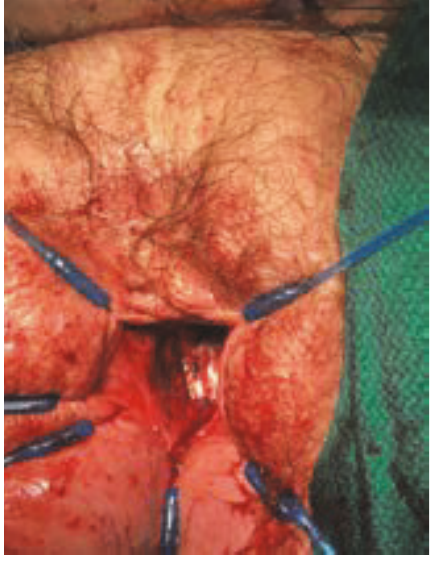
Figure 4: Final layer of bladder neck closure with the cadaveric pericardial tissue in